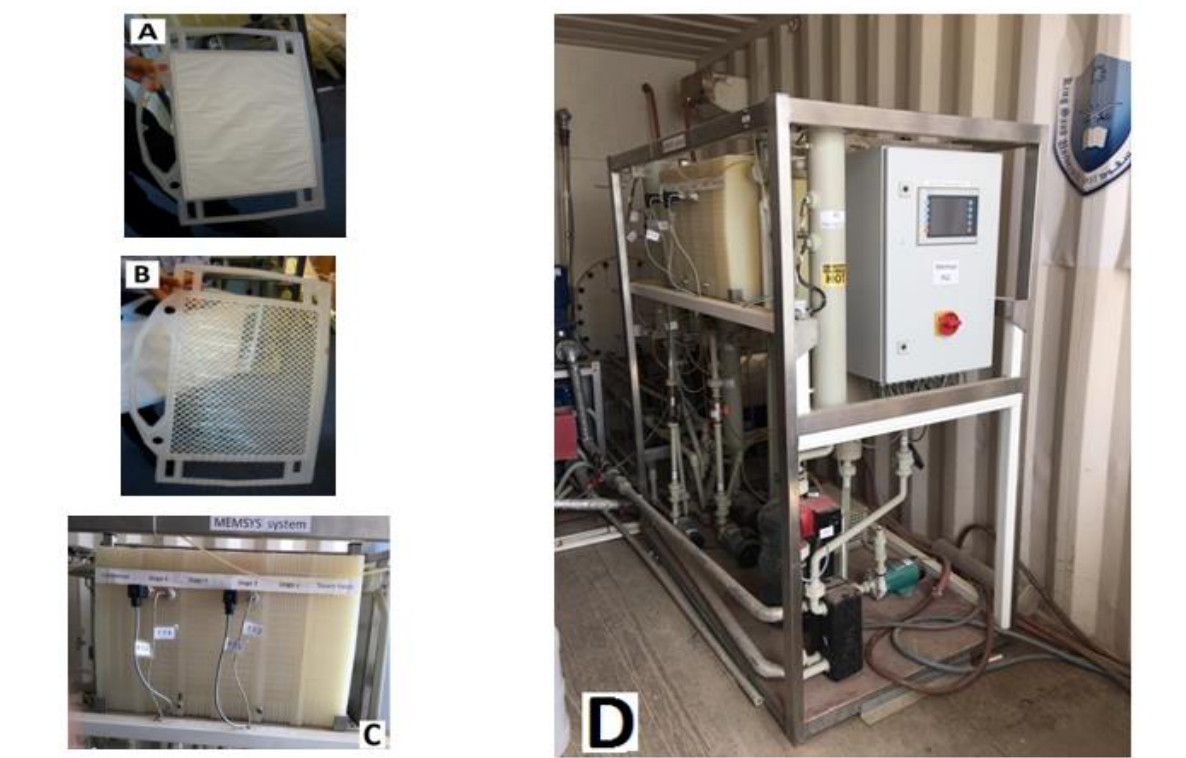
Figure 1. Photographs of pilot plant facilities ( A ) PP foil [19], ( B ) The hydrophobic membrane (PTFE) [19], ( C ) MD module, and ( D ) The V-MEMD unit. Table 2. Characteristics and specifications of the VMD unit.